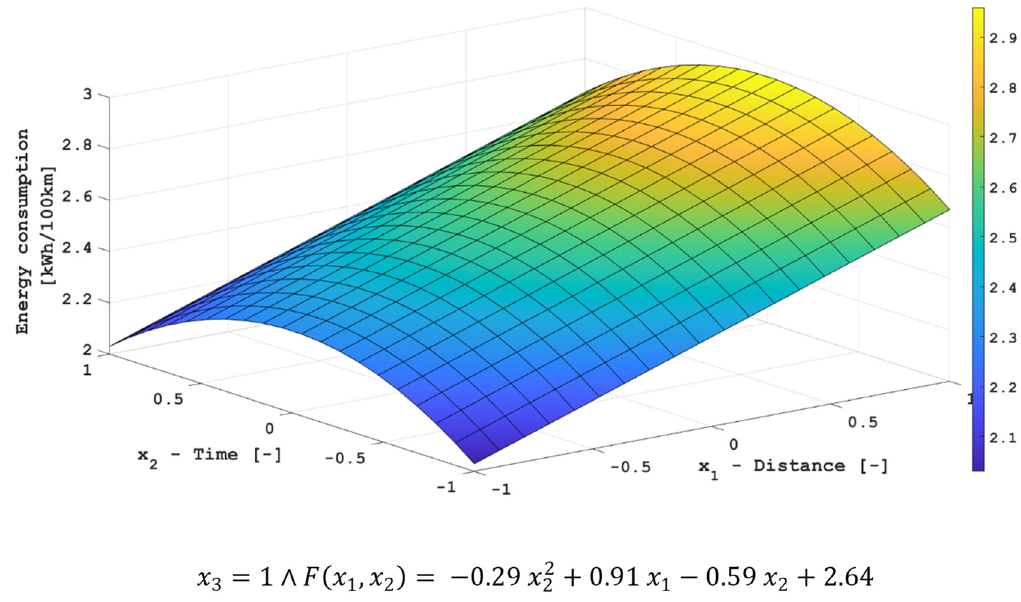
Figure 12. The values of consumption of an electric scooter at a temperature of 25 °C.